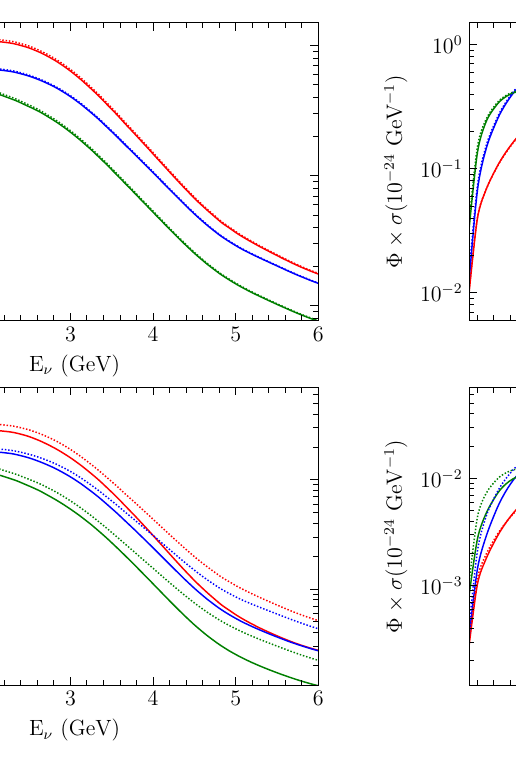
pseudoscalar couplings in red and blue, respectively. The green curve considers x 31 → ∞ , where the two types of coupling give the same